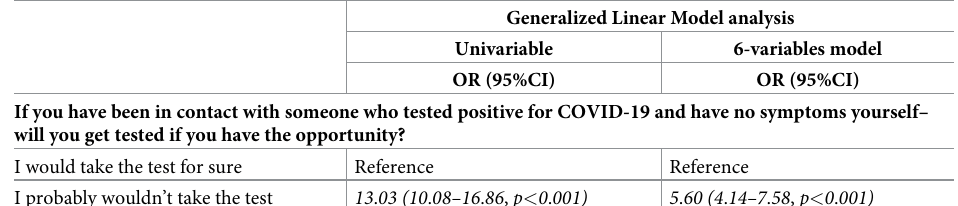
Table 2. Results of the Generalized Linear Model analysis showing variables associated with unwillingness to share contacts (see Supplementary for 20- and 10-variables models in S1